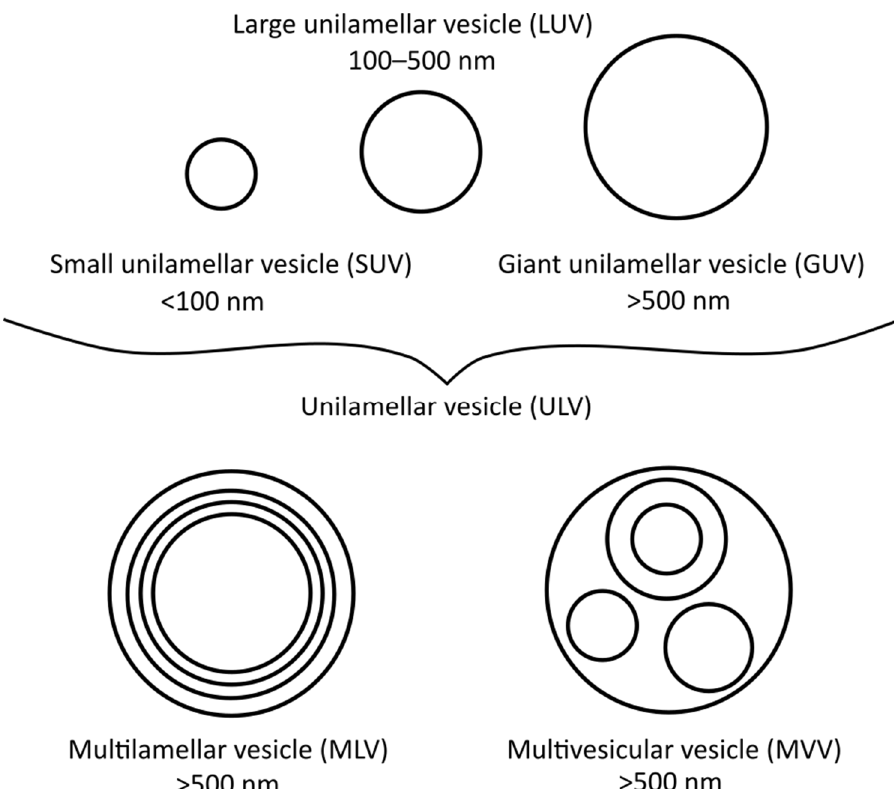
Figure 1. Different vesicle/liposome types and their diameters.